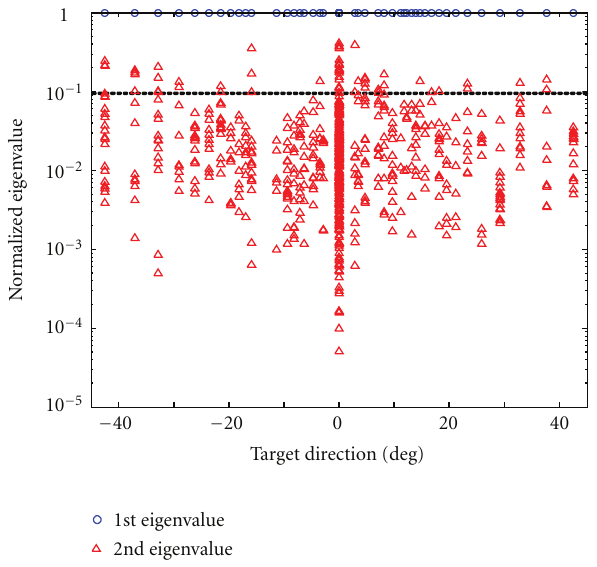
Figure 11: Normalized eigenvalue distribution derived from the measurements in outdoor